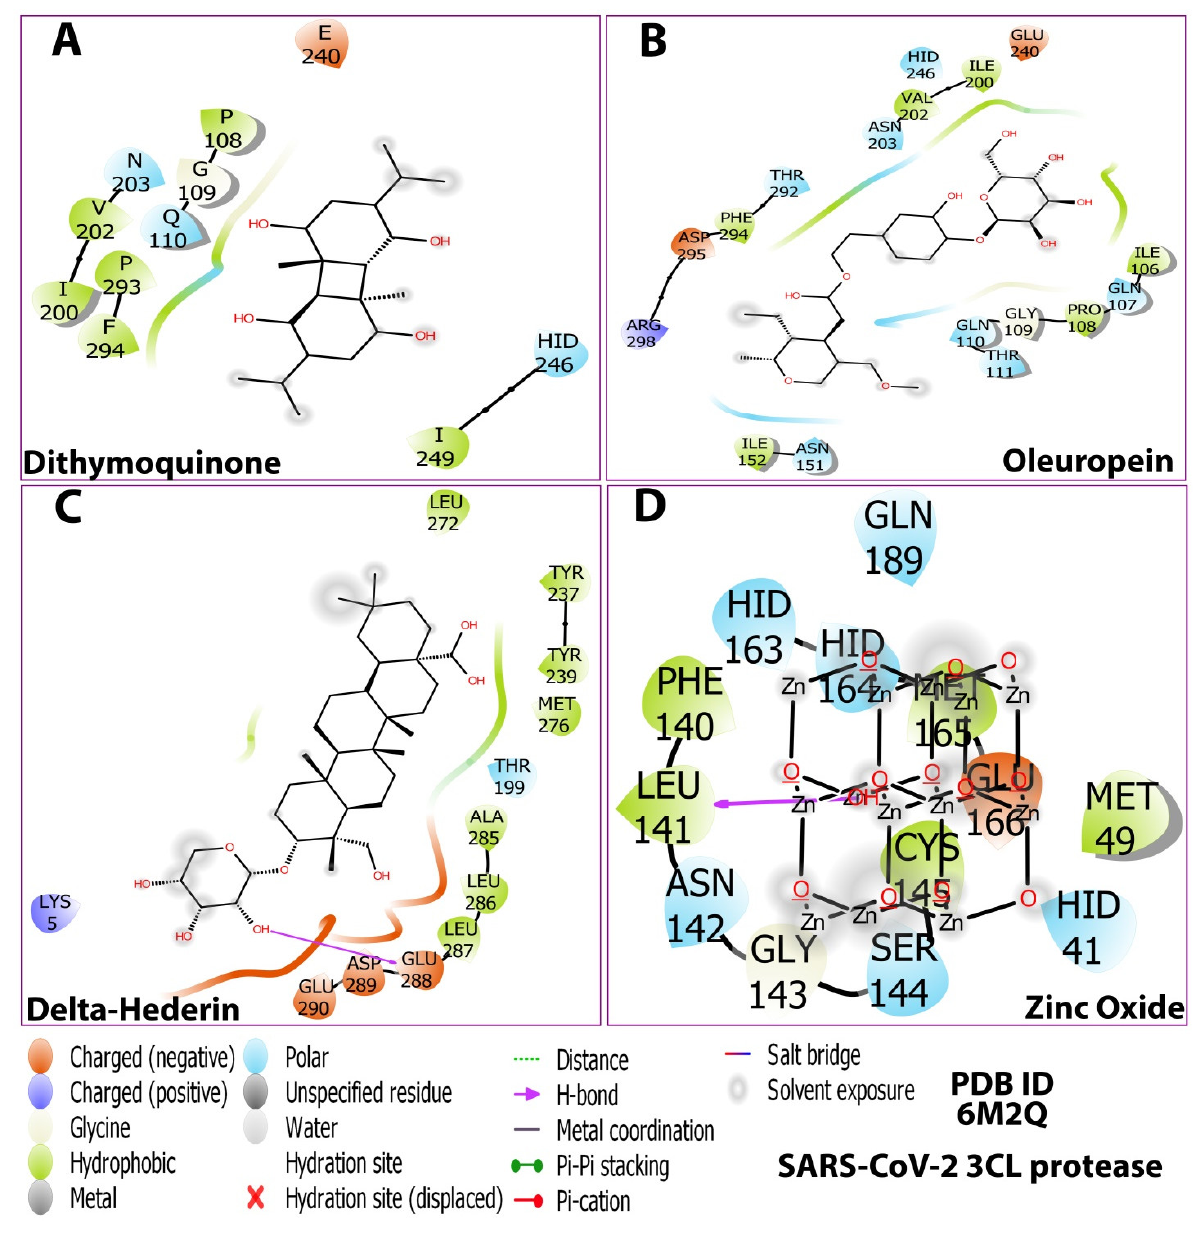
Figure 5. 2D Ligand–receptor interactions of optimized compounds in the zinc NLC with SARS-CoV-2 (3CLpro) displaying molecular interactions between the ligands and the amino acids of the protein. ( A ) dithymoquinone, ( B ) oleuropein, ( C ) delta-hederin (δ-hederin), ( D ) zinc oxide. Table 4. Binding energies (MMGBSA) of the complexes of matrix protein of 3CL protease and the selected